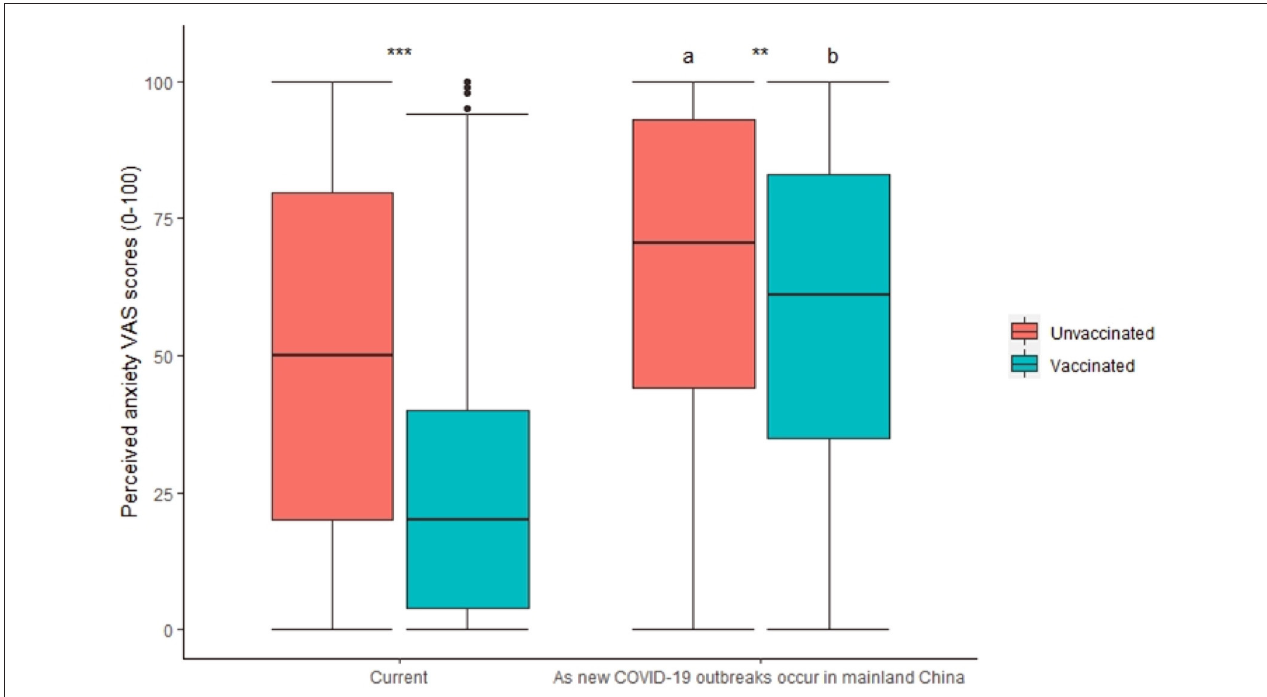
FIGURE 1 | Impact of COVID-19 vaccination status on perceived anxiety VAS scores. a, b, p < 0.05 in comparison with “Current”; ** p < 0.01; *** p < 0.001.